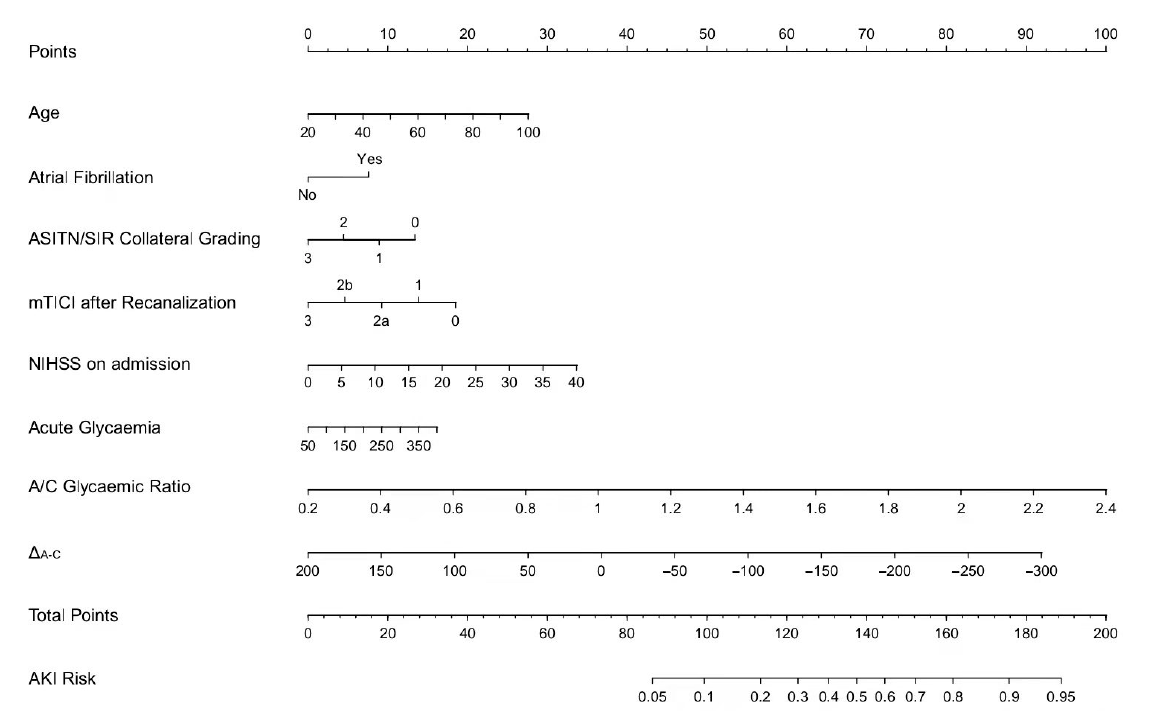
Figure 2. Nomogram predicting AKI in acute ischaemic stroke patients receiving EVT.